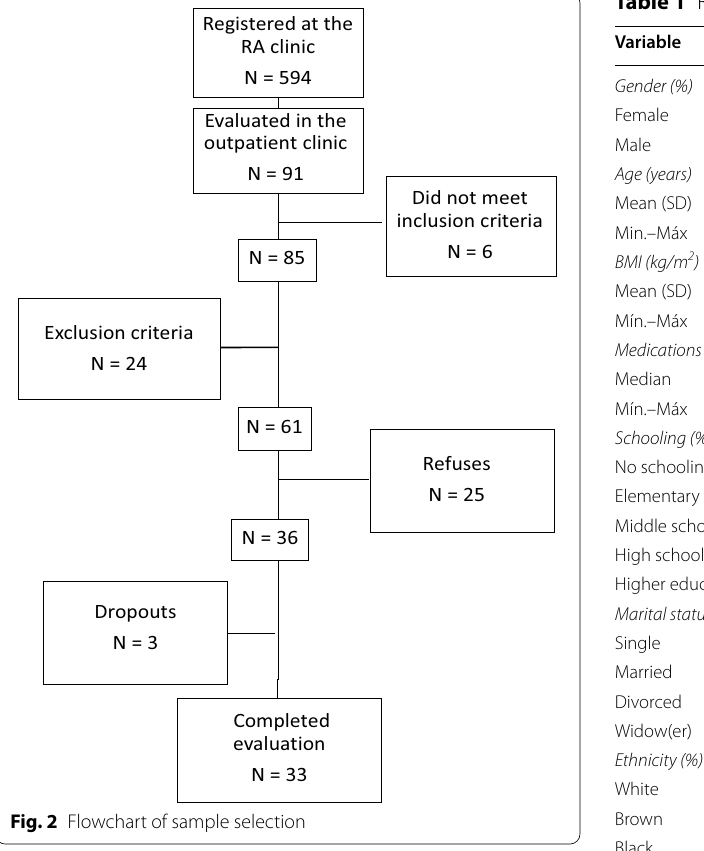
Table 1 Rheumatoid arthritis patients sample